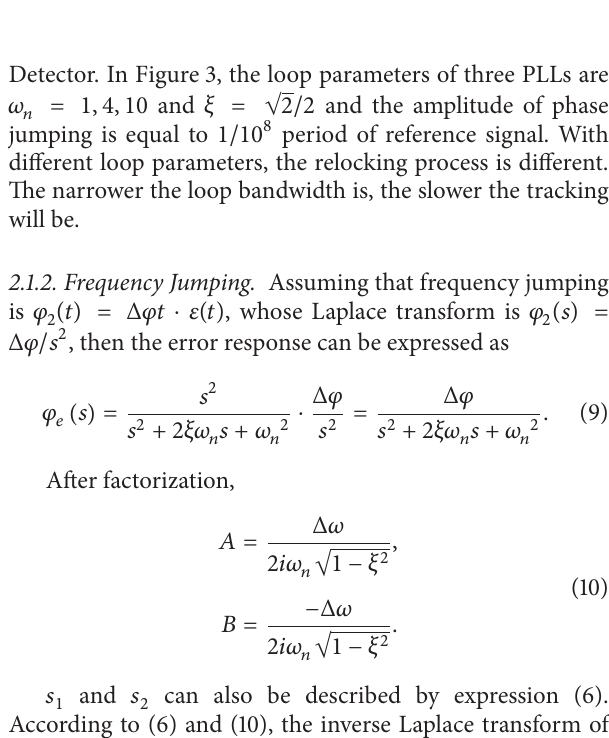
Figure 3: Response of Phase Detector to phase jumping during simulation.